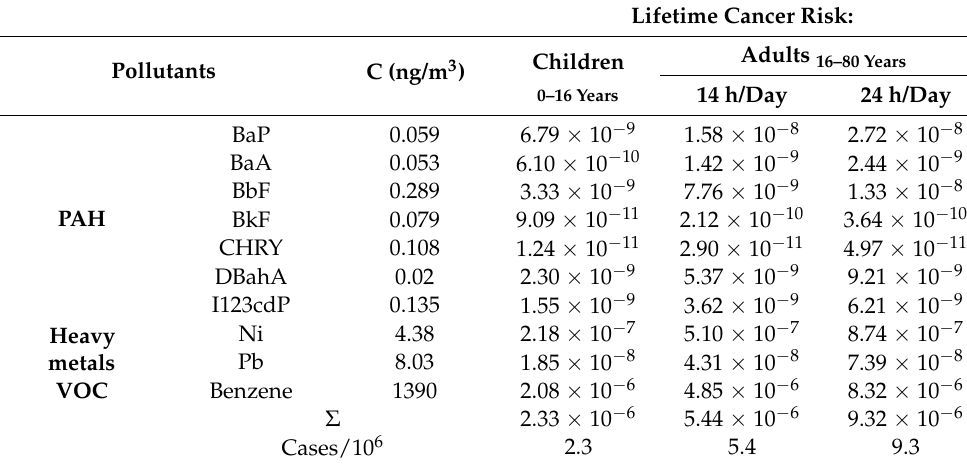
Table A11. Cancer risk assessment B.IV method (Megido, 2017).